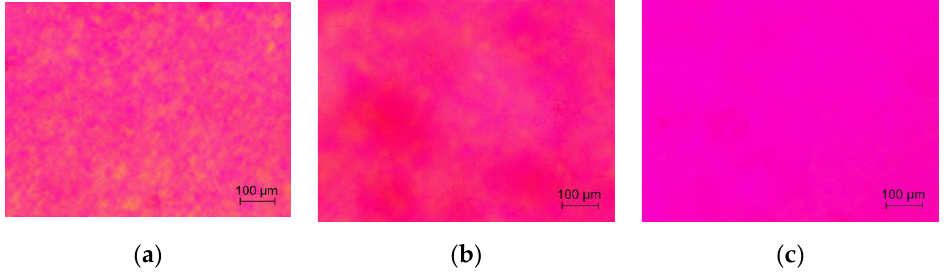
Figure 9. Transmission microscopy photographs with polarizing plates of the Y 2 O 3 ceramics: ( a ) hot-pressed, ( b ) HIP at 1200 °C for 20 h, and ( c ) HIP at 1600 °C for 2 h.